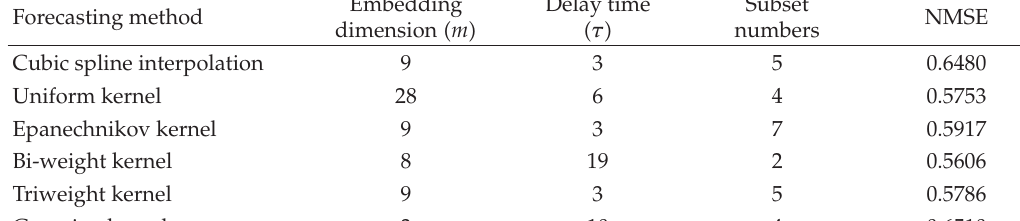
Table 2: The optimal results after selecting independent variable by Bootstrap method based on NPLS.